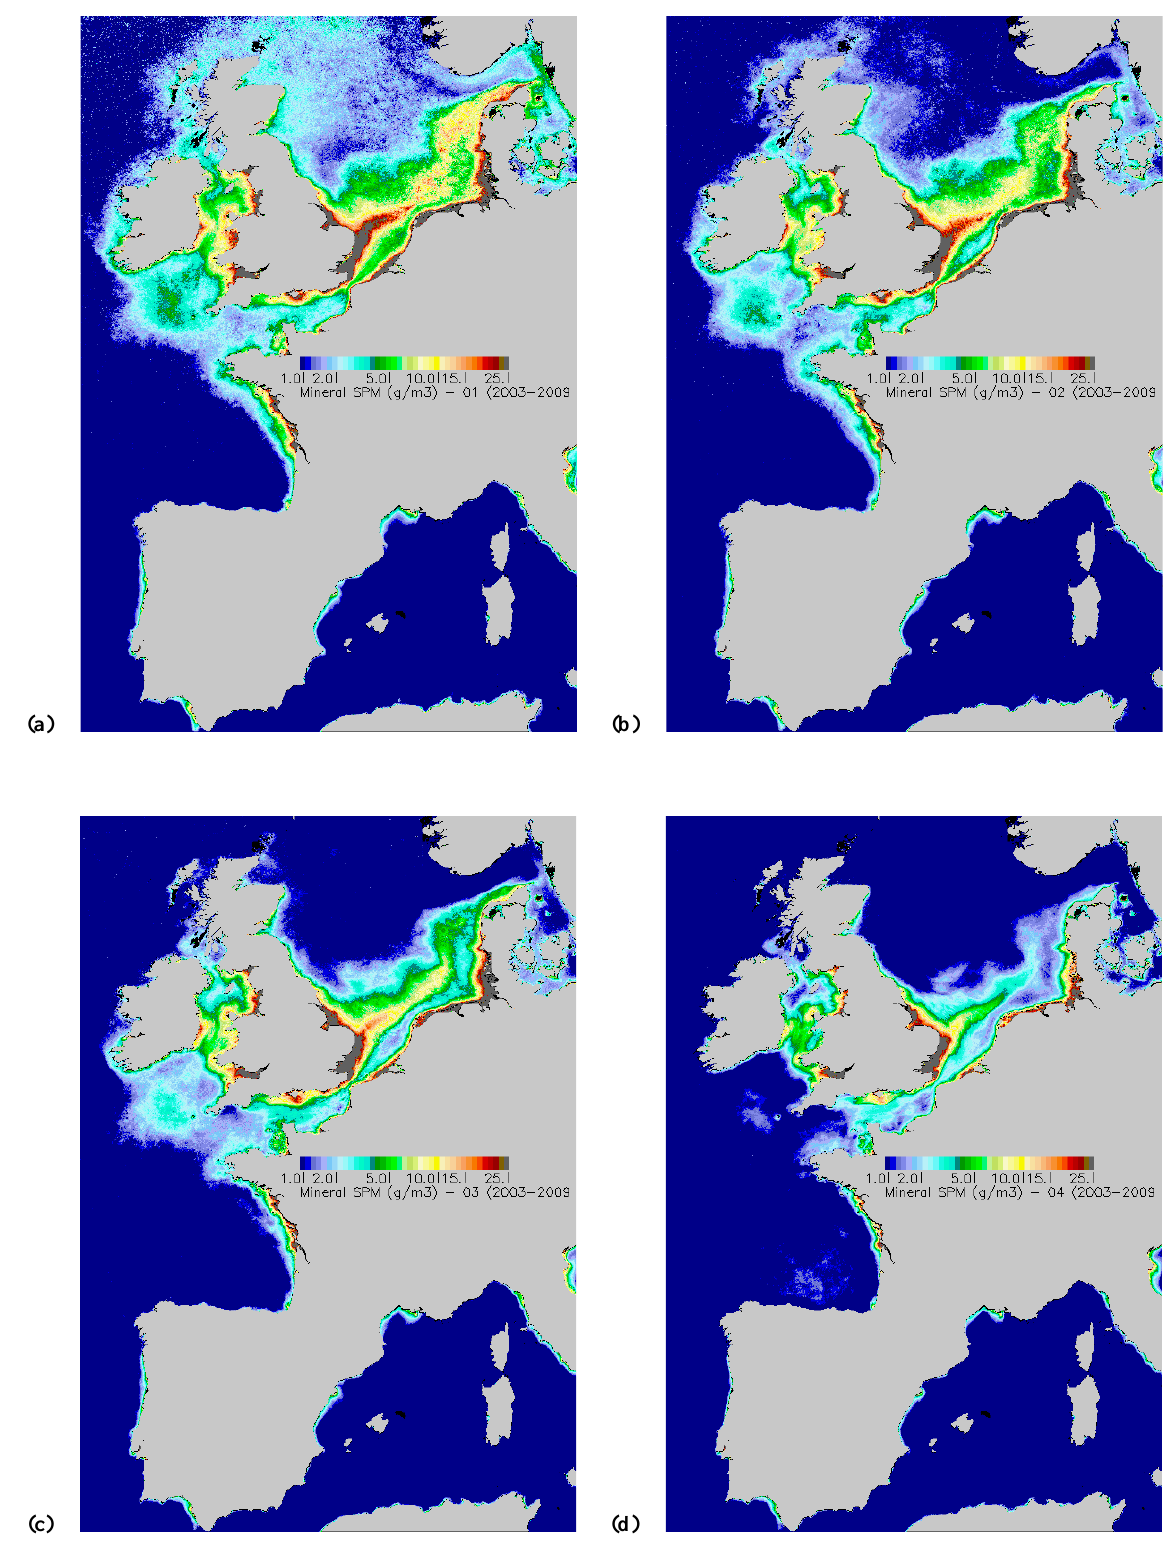
Fig. B1 Monthly non-algal SPM in January (a) , February (b) , March (c) and April (d)